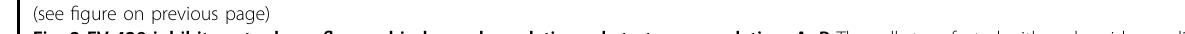
Fig. 2 FV-429 inhibits autophagy fl ux and induces degradative substrate accumulation. A, B The cells transfected with a plasmid encoding LC3-GFP-mcherry were incubated with 25 μ M FV-429 for 0~12 h in Jurkat and for 12 h in Hut102 cells. The LC3II puncta formation was detected by fl uorescence microscopy (scale bar: 10 μ m). C The Jurkat and Hut102 cells were treated with 25 μ M FV-429 and BAF A1 (50 nM, pre-treated for 1 h) for 12 h, and the protein expression of LC3 and p62 was determined by western blot. D The Jurkat cells were transfected with a plasmid encoding LC3- GFP and treated with 25 μ M FV-429 and BAF A1 (50 nM, pre-treated for 1 h) for 12 h. The LC3II puncta determined by fl uorescence microscopy, and LC3II-GFP puncta count were calculated (scale bar: 10 μ m; total puncta in each group >200). E The Jurkat and Hut102 cells were treated with 25 μ M FV-429 and rapamycin (500 nM, pre-treated for 2 h) for 12 h, and the protein expression of LC3 and p62 was determined by western blot. F The Jurkat cells were transfected with a plasmid encoding LC3-GFP and treated with 25 μ M FV-429 and rapamycin (500 nM, pre-treated for 2 h) for 12 h. The LC3II puncta determined by fl uorescence microscopy, and LC3II-GFP puncta count were calculated (scale bar: 10 μ m; total puncta in each group >200). G The Jurkat and Hut102 cells were treated with 25 μ M FV-429 for 12 h. The immuno fl uorescence analysis was performed with anti-p62 antibody (green), anti-LC3 antibody (red; autophagosomes), and DAPI (blue; nuclei). The counts of p62 puncta and co-localization of p62 and LC3 were calculated (scale bar: 10 μ m, the cells calculated in each group >100). H The Jurkat cells were treated with 25 μ M FV-429 for 0~8 h and the expressions of ubiquitin were determined by western blot. β -actin used as loading control in western blot (mean ± s.e.m. for 3 independent experiments; p values are shown on the